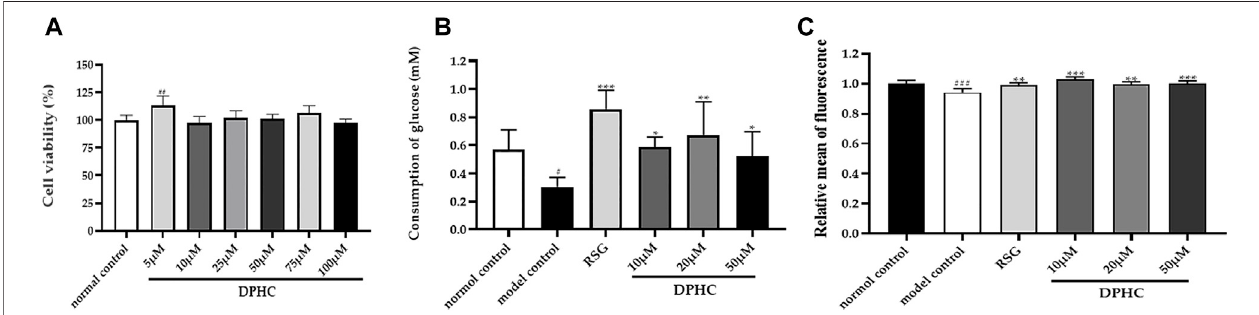
FIGURE8|(A) Effect ofdifferentconcentrationsofDPHCon theviability ofHepG2cells for24 h. (B) Glucose consumption. (C) Quantify fl uorescence toshow the results of glucose uptake. All values are expressed as means ± SD, n (cid:1) 4. * p < 0.05, ** p < 0.01, *** p < 0.001 compared with the model control group, and ## p < 0.01, ### p < 0.001 compared with the normal control group.